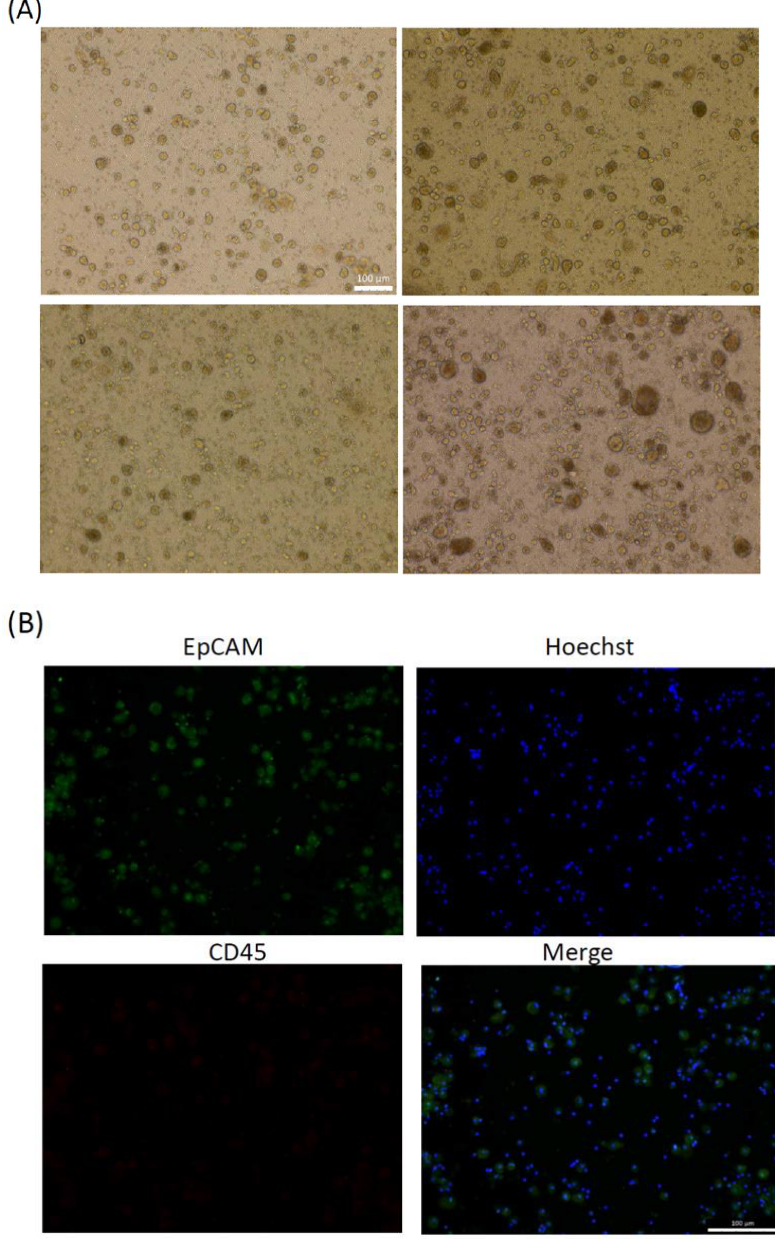
Figure 2. Expansion of ex vivo of circulating tumor cells (CTCs) derived from patients with HNC. ( A ) Representative bright-field images of organoids expanded ex vivo from CTCs derived from patients with HNC. Scale bar: 100 μm. ( B ) Epithelial cell adhesion molecule (EpCAM), or CD45 immunostaining, and Hoechst staining results for organoids to ascertain the presence of CTCs. Scale bar: 100 μm.